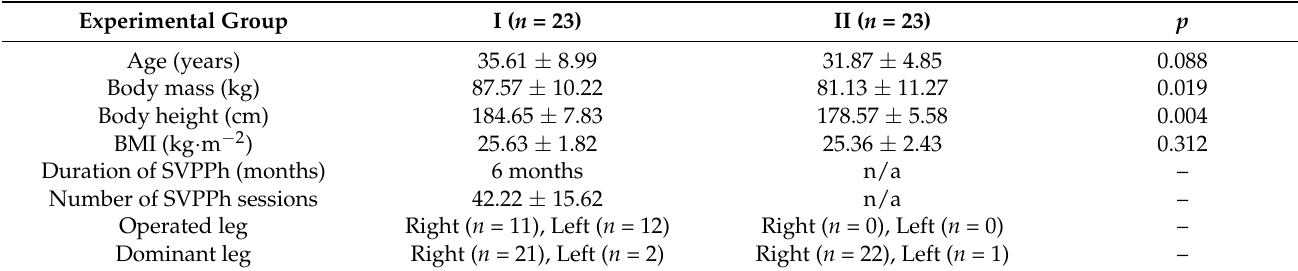
Table 1. The between-group comparison of the values corresponding to body mass, body height, age, body mass index (BMI), the duration of postoperative physical therapy, and the number of postoperative physical therapy sessions. Experimental